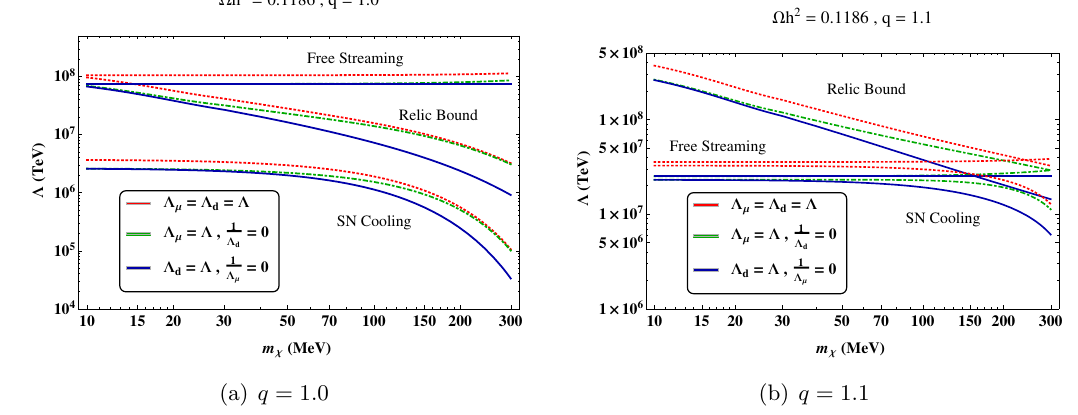
Figure 6 . (cid:3) (in TeV) (obtained from SN1987A cooling, free streaming [7] and using Relic bound) is plotted against m (cid:31) (in MeV) for undeformed ( q = 1) and q -deformed